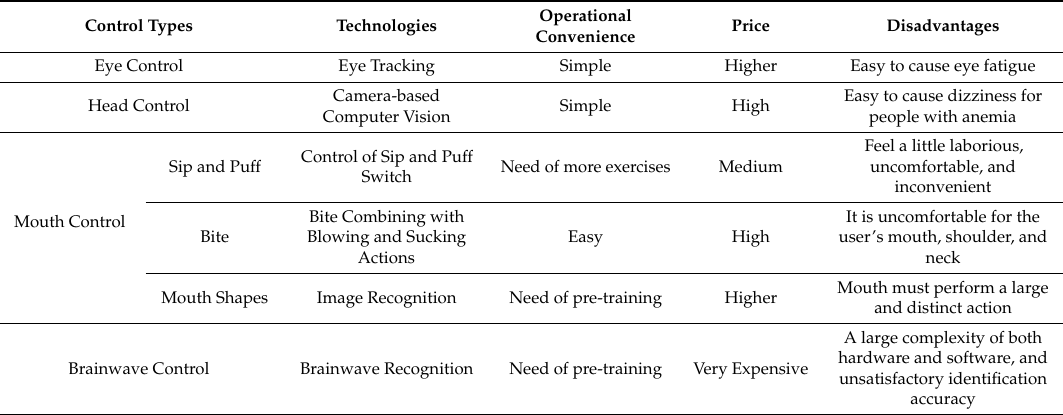
Table 1. Comparison of di ff erent mouse assistive